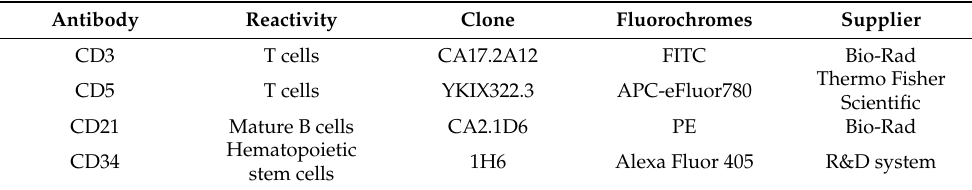
Figure 4. Flow cytometry (FC) of the right prescapular lymph node (LN) and peripheral blood (PB). Forward versus side scatter plots show the placement of the lymphoid cell gate in right prescapular LN and PB. The cells shown in two-parameter density plots with four quadrants were gated on the singlet lymphoid cell populations after doublet exclusion. ( A ) Right prescapular LN. Note that approximately 90% of lymphoid cells in the right prescapular LN show simultaneous CD3 and CD21 positivity (red squares). ( B ) PB. Note that approximately 90% of lymphoid cells in the PB only show CD21 positivity (red squares). Table 2. Antibodies for flow cytometry (FC) analysis used in the case.